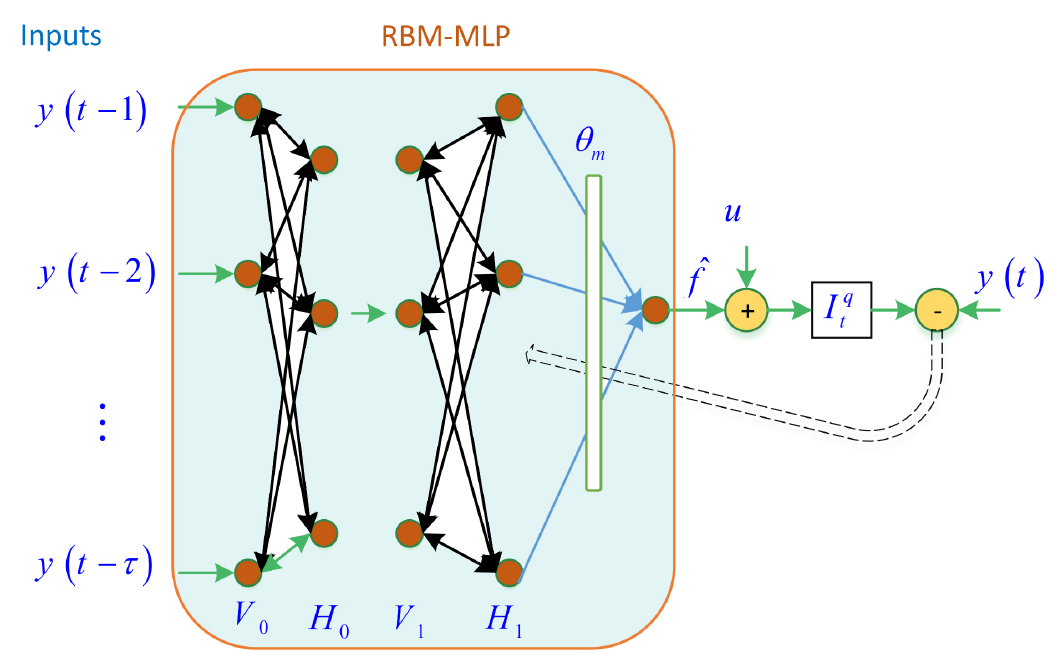
Figure 4. The suggested fractional-order dynamic RBM-MLP block